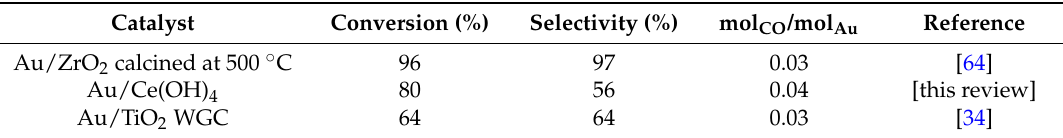
Table 5. Physico-chemical properties of the samples and catalytic performances.